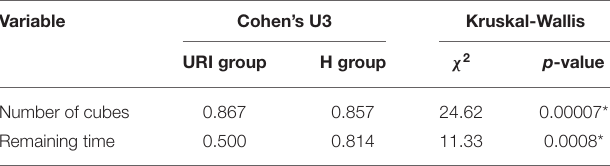
TABLE 3 | Statistical differences between the hospital (URI) group and the home (H) group in exergaming. Variable Cohen’s U3 Kruskal-Wallis URI group Number of